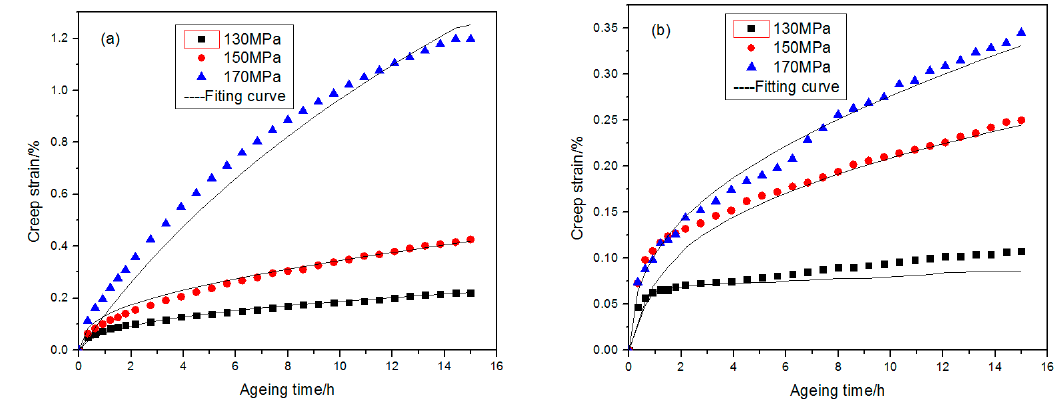
Figure 5. Comparison of fitted values and measured values of 2219 aluminum alloy creep curves at ( a ) 438 K and ( b ) 418 K.